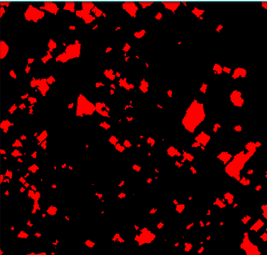
Figure 7 Building features extraction rule, Compactness